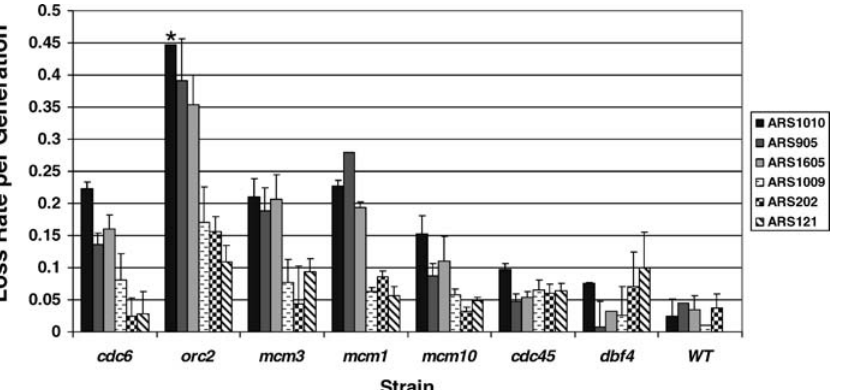
Figure 5. Comparing the Effect of mcm1–1 on A-Type and B-Type ARSs with Those of Pre-RC Assembly (cdc6, orc2, and mcm3) and Activation (cdc45 and dbf4) Mutants as Well as mcm10 in a mcm Assay The asterisk indicates rate was too high to be measured. ARS1010, ARS905, and ARS1605 are B-type ARSs. ARS1009, ARS202, and ARS121 are A-type ARSs. DOI: